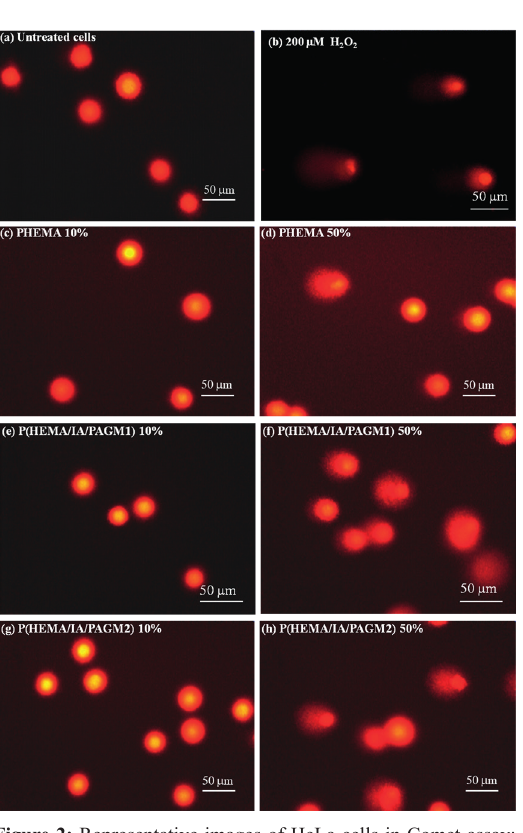
Figure 2: Representative images of HeLa cells in Comet assay; untreated cells (a), cells treated with 200 μM H treated with two concentrations (10% and 50%) of PHEMA (c, d), P(HEMA/IA/PAGM1) (e, f) and P(HEMA/IA/PAGM2) (g, h) hydrogels’ extracts. Magnification ×400.